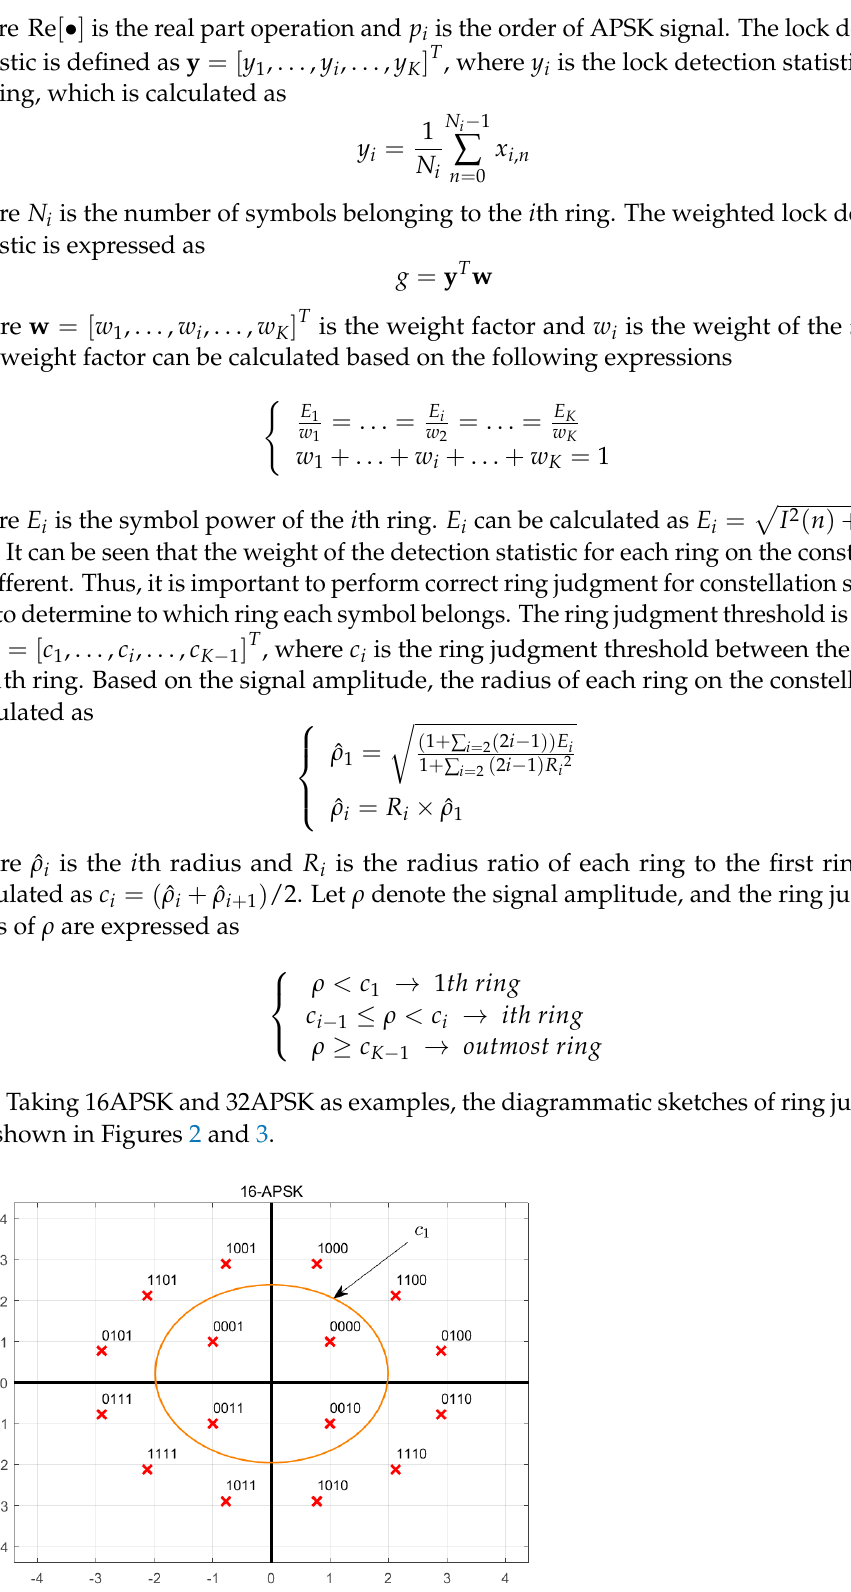
Figure 3. Diagrammatic sketch of ring judgment for 32APSK signals. 4. Performance Analysis The performance of the lock detector is evaluated using the lock detection probabil- ity; it can be analyzed based on the statistic characteristics of the detection statistic, which is proposed in Section 3. The statistic characteristics of the detection statistic consist of expectation and variance. Thus, in this section, the expectation and variance of the pro- posed detection statistic are firstly derived under two conditions (lock and unlock). Then, the lock detection probability of the proposed detector is analyzed. Finally, the selection principle of the number of symbols used for accumulation is given. 4.1. Expectation and Variance The output of the lock detector can distinguish the locked and unlocked states of carrier synchronization so as to realize the decision of the carrier synchronization state. When N is large enough, the output characteristics of the lock detector can be evaluated using the expectation and variance of